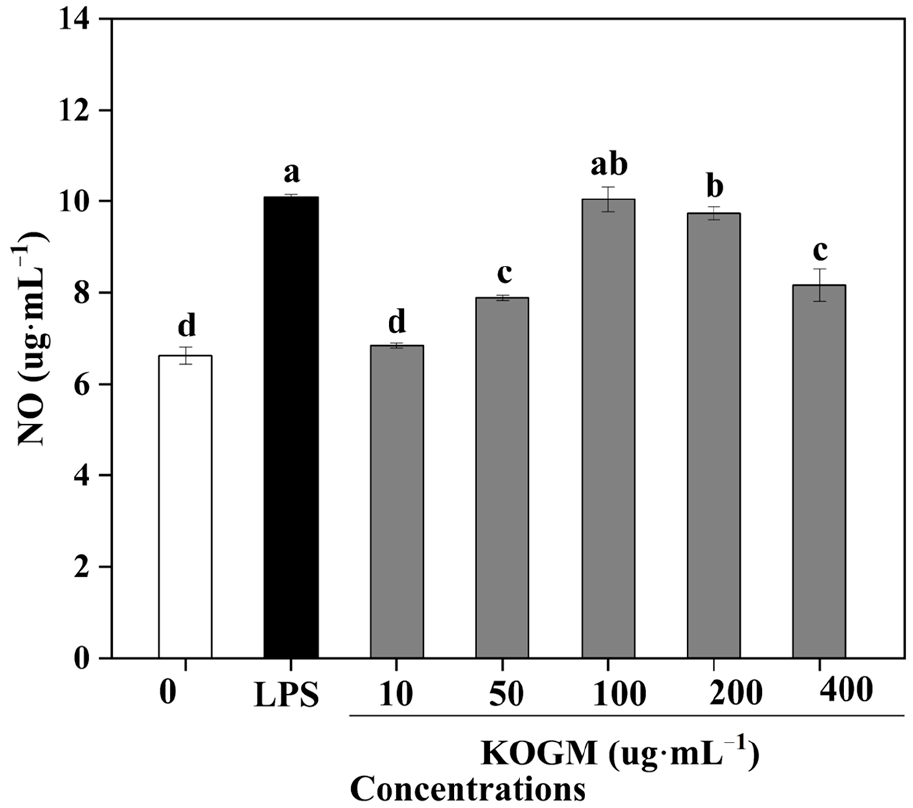
Figure 8. Effects of W. cibaria F1 mannanase on production of NO of RAW264.7 macrophages in vitro. Different letters in superscript donate significant difference ( p < 0.05).